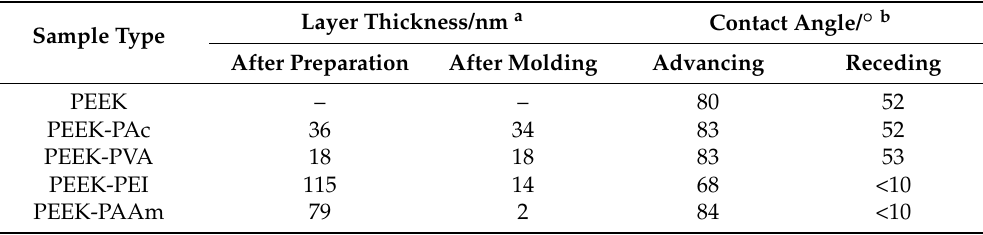
Table 1. Characteristics of the PEEK part